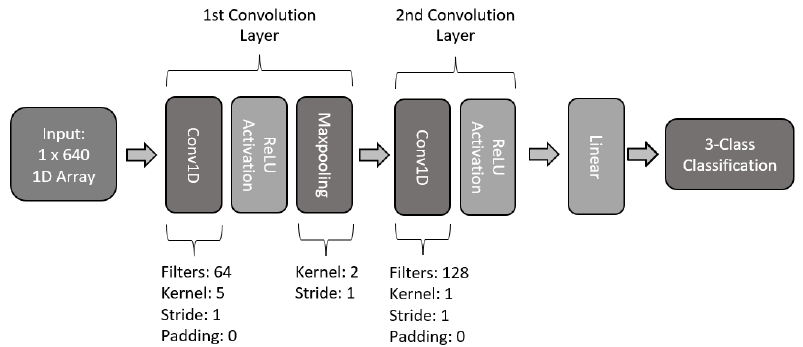
Figure 16. Architecture of two-layer 1D CNN model.